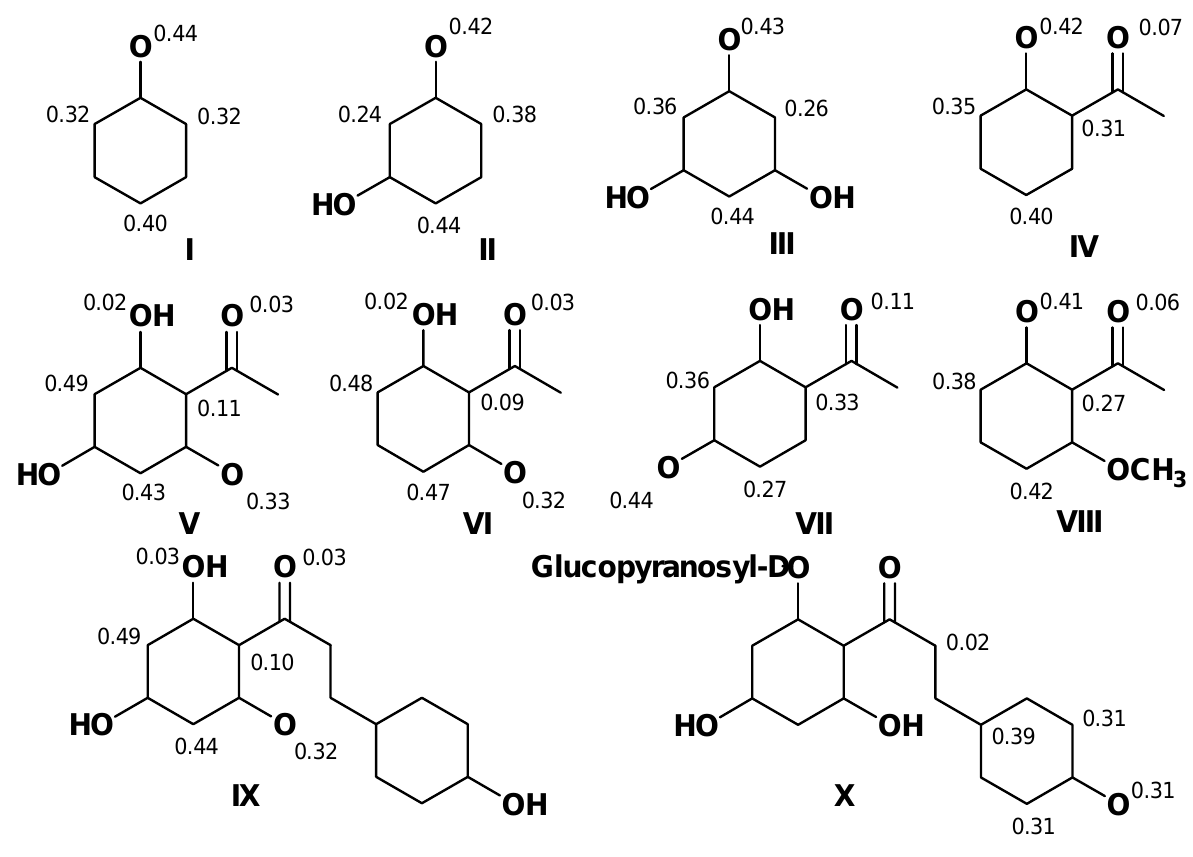
Figure 5. Spin densities for the more stable semiquinone